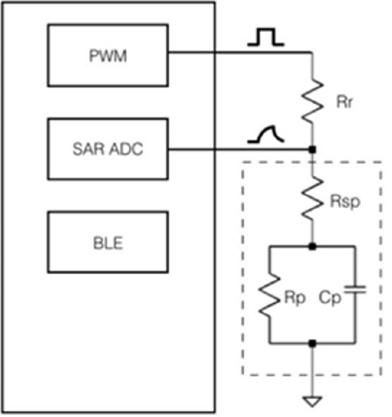
Figure 7. Sensor node schematic diagram.